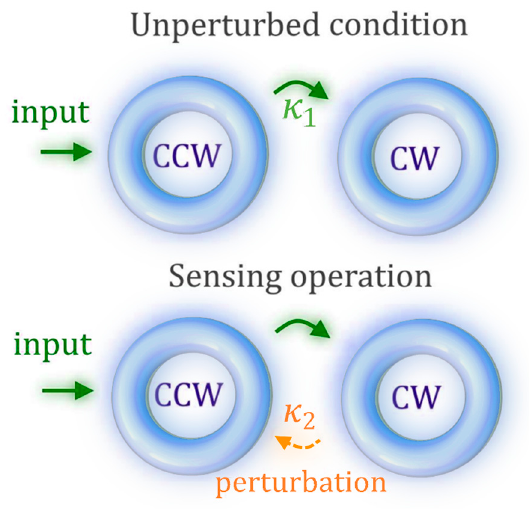
Figure 6. Exceptional surface-based configuration, illustrating schematically two non-reciprocally coupled modes within one optical resonator.